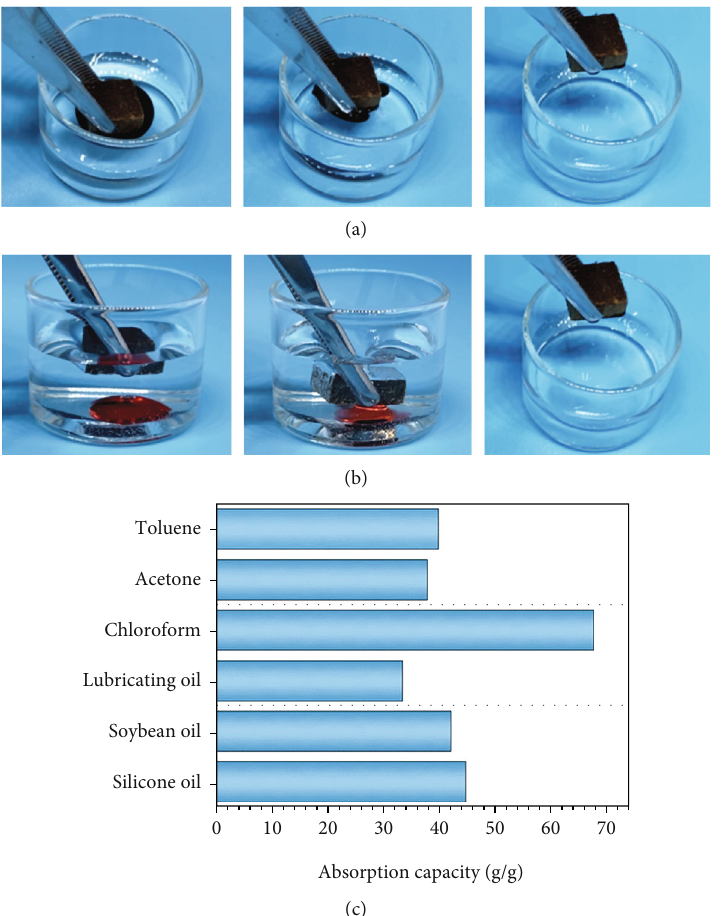
Figure 7: Absorption capacity of DDT-0.5PDA@CNF toward some oily liquids (a), separation the dyed toluene (b) and (c) chloroform from the water phase with